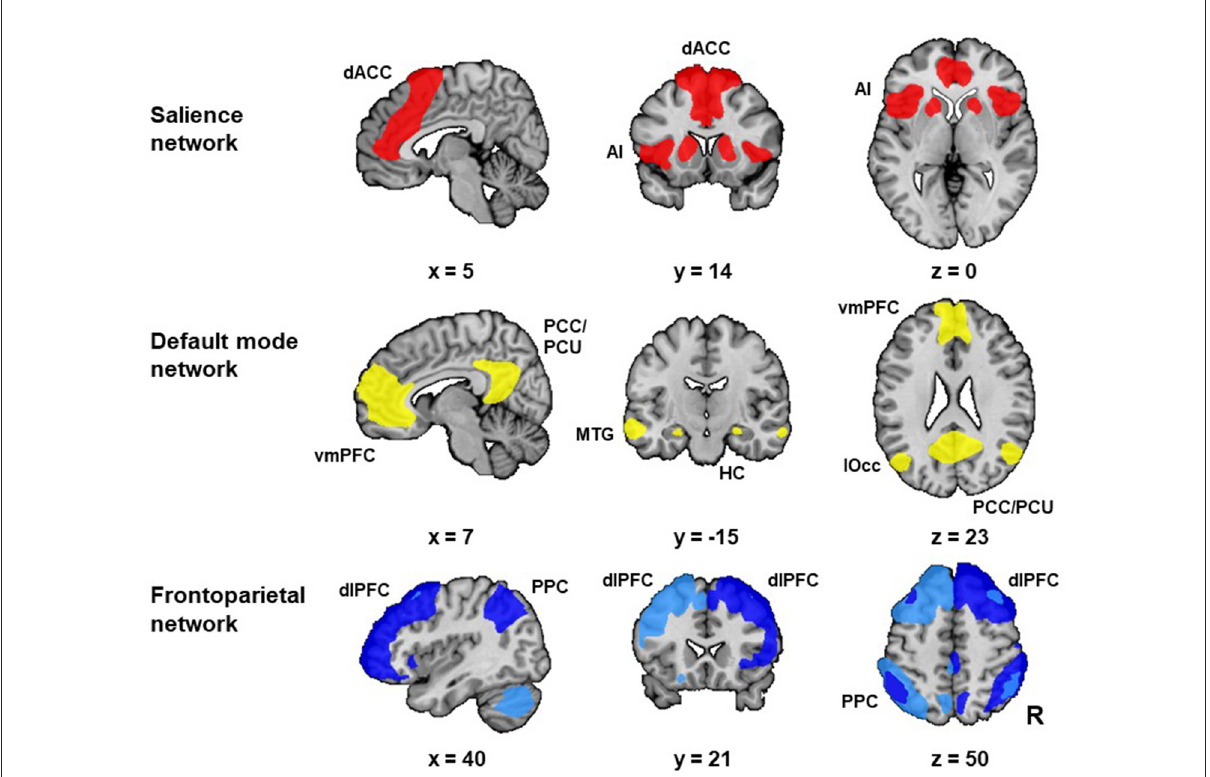
FIGURE2 Networks of interest. The networks of interest [i.e., the salience network (SN), default mode network (DMN) and frontoparietal network (FPN)] were identified with group independent component analysis (ICA) in resting-state scan 1. We identified two FPNs: the left FPN (light blue) and right FPN (dark blue). The selected networks included all areas that are typically considered as core regions in these networks. The SN included the bilateral anterior insula (AI) and dorsal anterior cingulate cortex (dACC). The DMN included the ventromedial prefrontal cortex (vmPFC), posterior cingulate cortex (PCC) and precuneus (PCU). Additionally, the DMN included the hippocampus (HC), middle temporal gyrus (MTG) and lateral occipital cortex (lOcc). Both FPNs included the dorsolateral prefrontal cortex (dlPFC) and posterior parietal cortex (PPC). Abbreviation: R: right. [Figure adapted from van Oort et al.